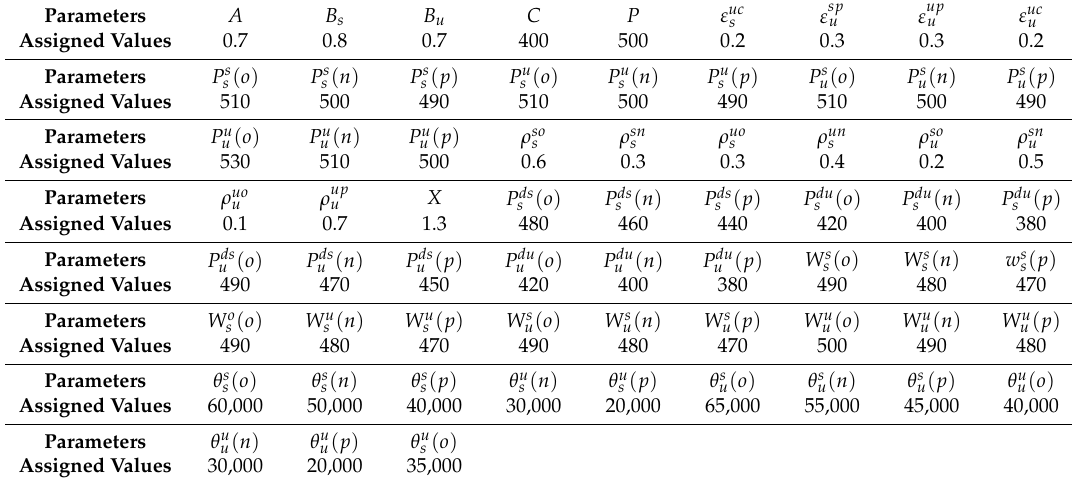
Table 1. All assigned parameters for the proposed model with numerical examples.